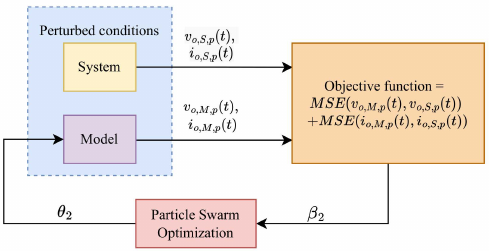
Figure 8. Block diagram illustrating the parameter estimation methodology used during step 2.